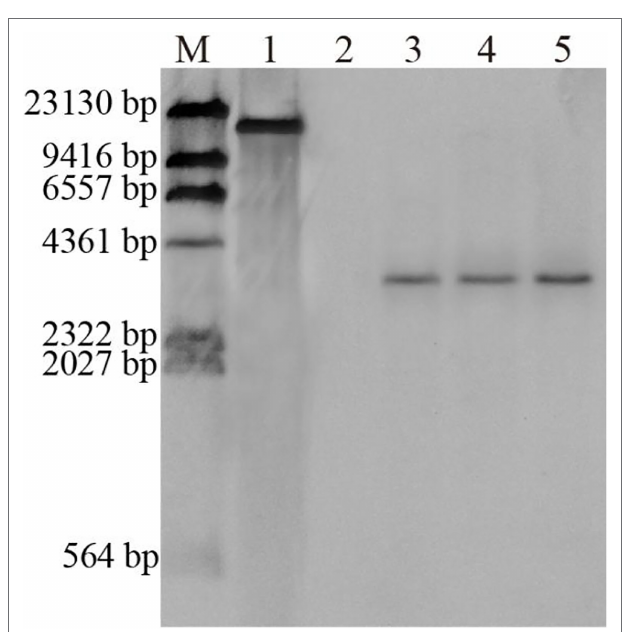
FIGURE 9 | Southern hybridization of genomic DNA from non-transformed and transgenic plants of the Liriodendron hybrid. Lane M, DNA Molecular- Weight Marker, DIG-labeled; Lane 1, plasmid DNA (positive control); Lane 2, non-transformed plants; Lanes 3–5, transformed